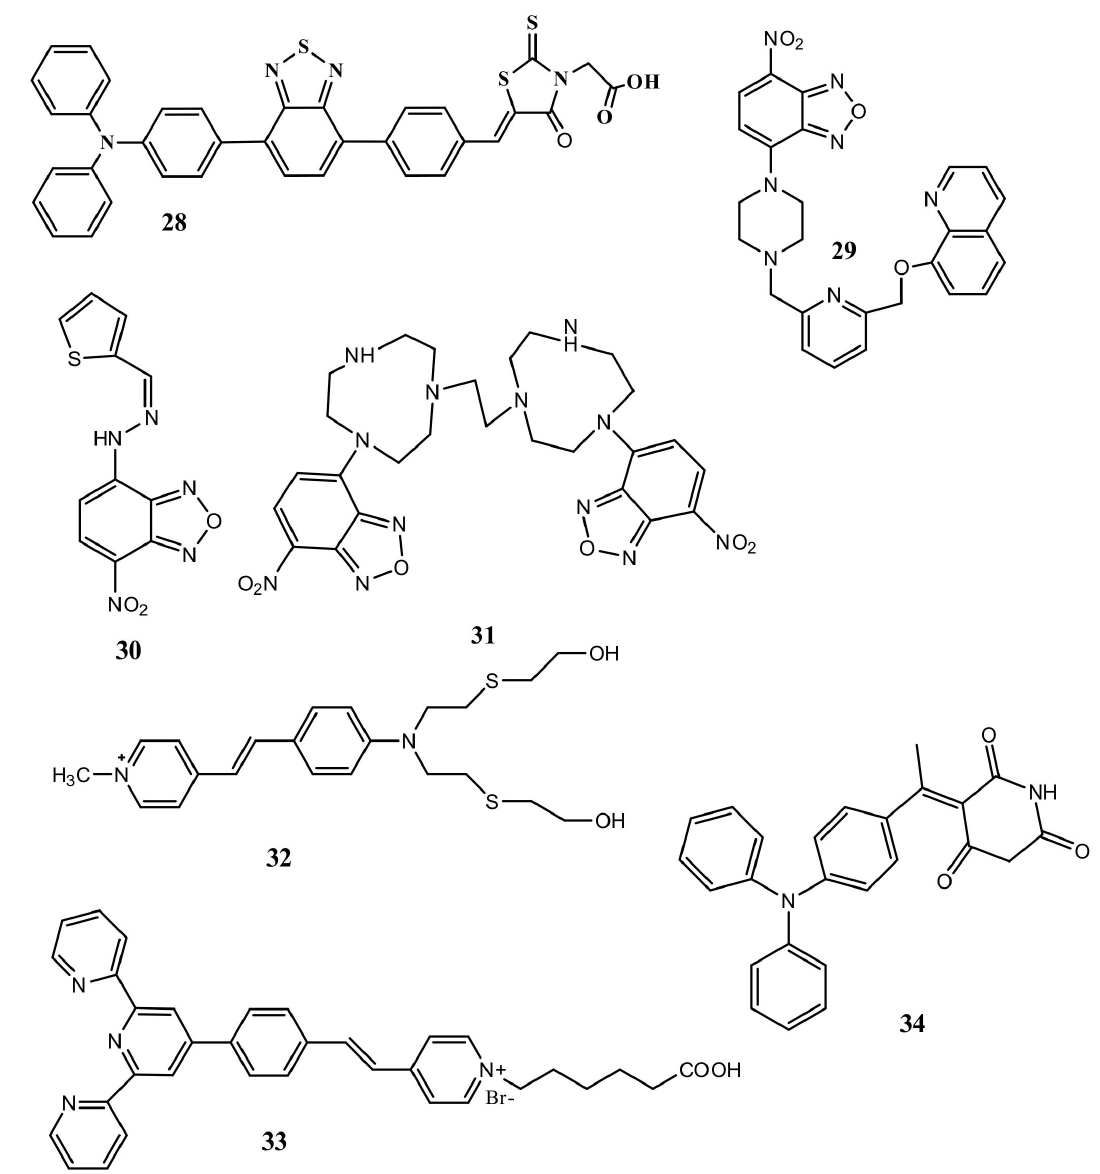
Figure 11. Molecular structures of the sensors 28 to 34